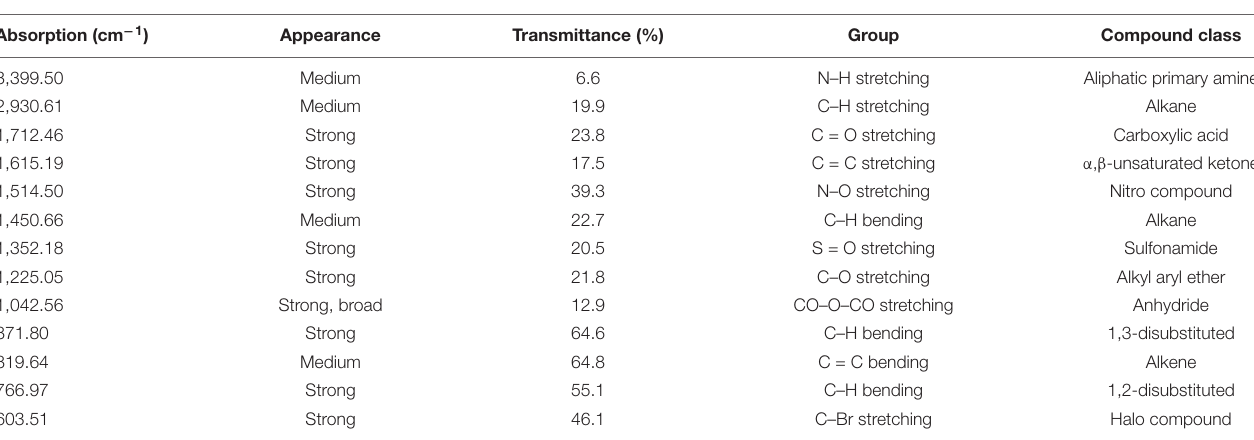
FIGURE 1 | Phytochemical screening by FTIR spectroscopic analysis of Eucalyptus camaldulensis leaf extracts. TABLE 1 | FT-IR spectrum of Eucalyptus camaldulensis